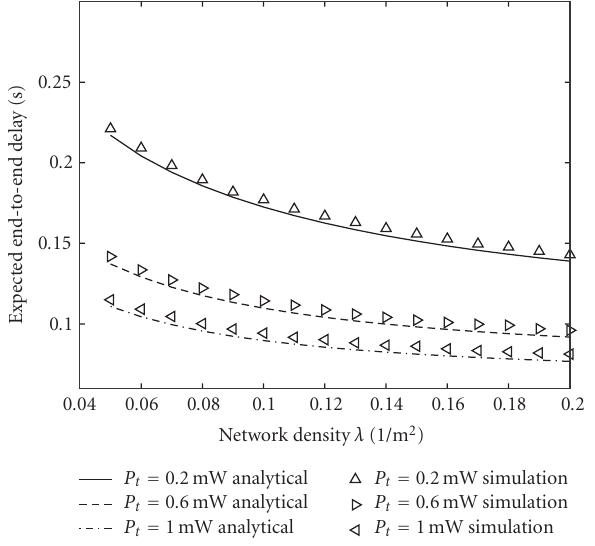
Figure 8: Expected delay versus network density λ ( l = 160m).